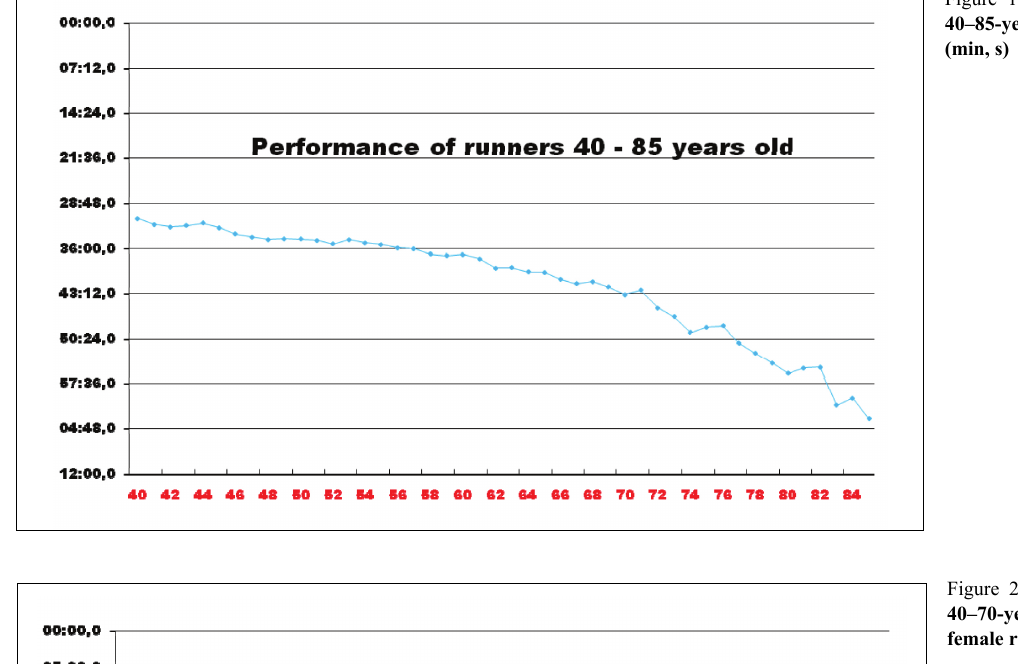
Figure 2. Performance of 40–70-year-old male